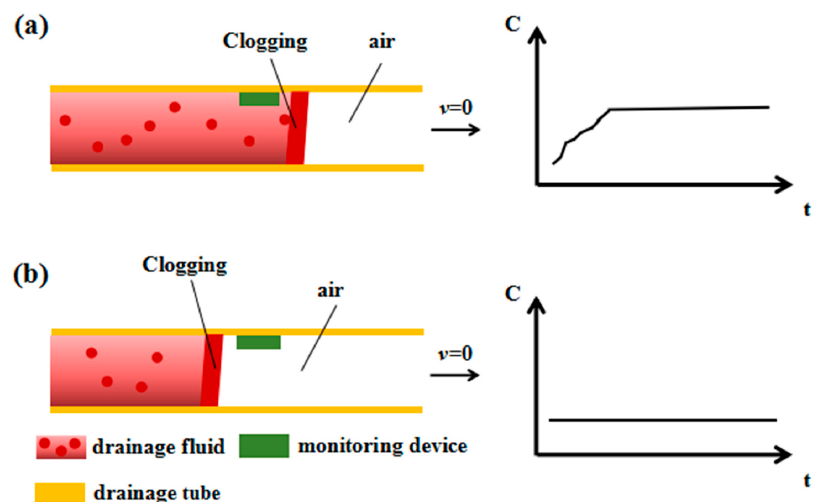
Figure 3. Schematic diagram of the flow state and the output of the sensor when the drainage tube is blocked. ( a ) The working state diagram of the drainage tube and the corresponding capacitance change curve of the sensor when the pipeline is blocked and the blocking position is behind the sensor. ( b ) The working state diagram of the drainage tube and the corresponding capacitance change curve of the sensor when the pipeline is blocked and the blocking position is in front of the